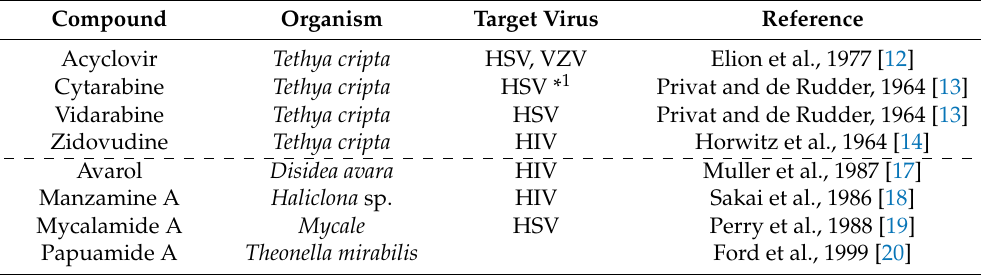
Figure 3. Chemical structures of nucleic acid analogs clinically used as key antivirals today, together with those of analogous competitors. Acyclovir (ACV) is used for the treatment of herpes simplex virus infections, chickenpox, and shingles. ACV inhibits viral DNA polymerase activity in a deoxyguanosine triphosphate (dGTP)-competitive manner. Vidarabine (Ara-A) is active against herpes simplex and varicella zoster viruses. Ara-A inhibits viral DNA polymerase activity in a deoxyadenosine triphosphate (dATP)-competitive manner. Azidothymidine, also called zidovudine (AZT), is the most common drug prescribed for individuals who have acquired immune deficiency syndrome (AIDS). AZT inhibits viral reverse transcriptase (RT) activity in a deoxythymidine triphosphate (dTTP)-competitive manner. The key structural features are highlighted in yellow. Table 2. Sponge-derived antivirals reported in the latter part of the twentieth century. Compounds below the horizontal dotted line are more recent medicines. HIV—human immunodeficiency virus.